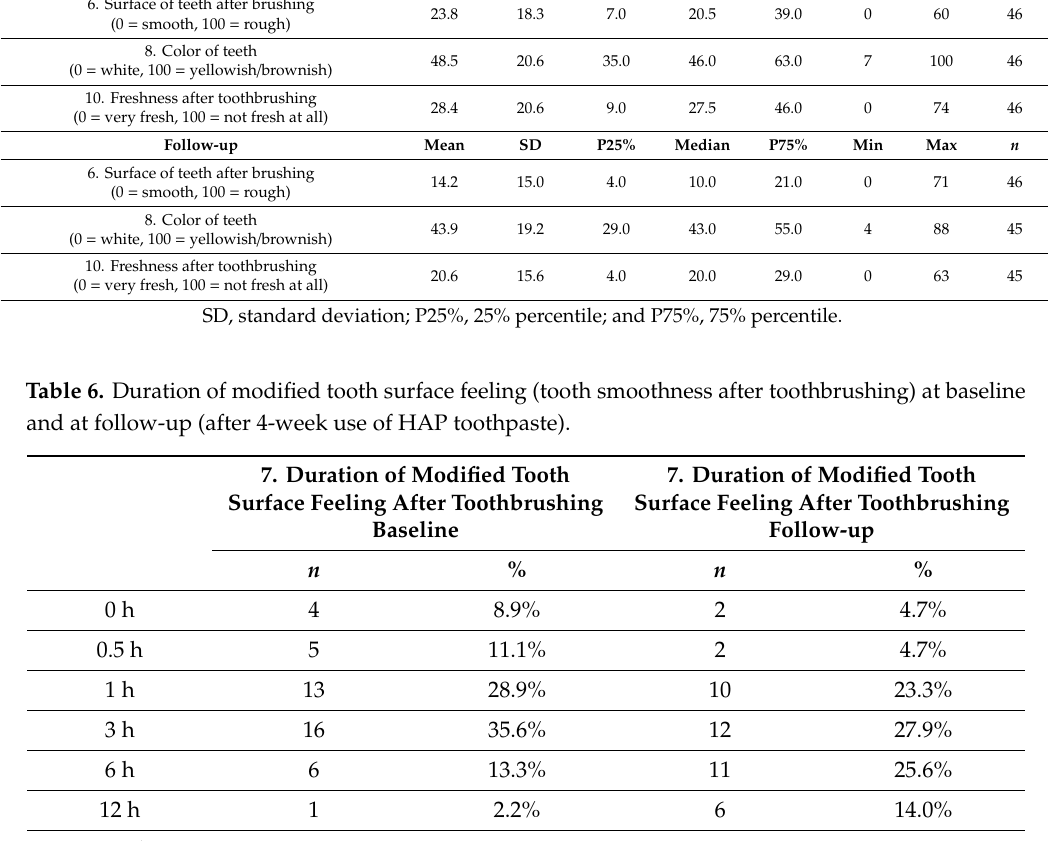
Table 5. Subjective parameters of dental care convenience (tooth surface, color of teeth, and freshness after tooth-brushing) at baseline and at follow-up (after 4-week use of HAP toothpaste). Mean SD P25% Median